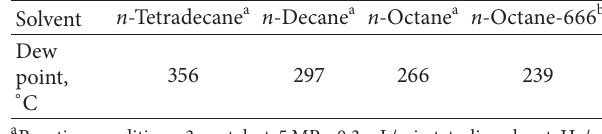
Figure 4: Tetralin conversion in 𝑛 -octane under different H 2 /oil ratio (250 ∘ C). Table 1: Dew points of feeds with different